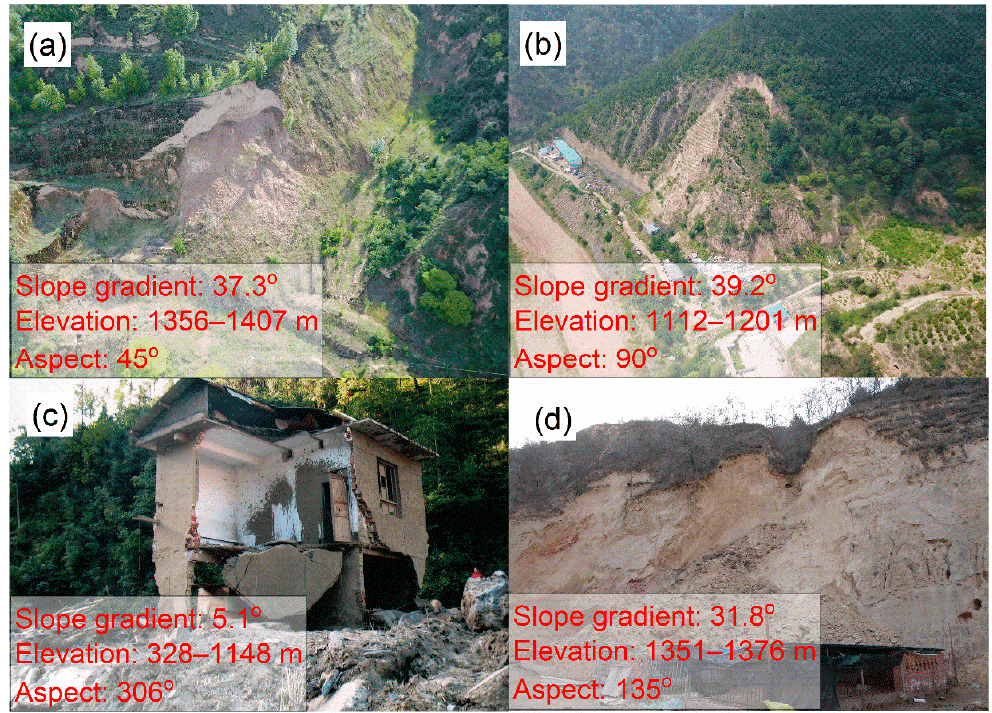
Figure 2. Photographs of typical landslides in the study area. ( a ) The slide that occurred on 30 July 2017 at 108°40 ′ 38 ″ , 36°53 ′ 39 ″ . ( b ) The slide that occurred on 1 August 2017 at 109°19 ′ 10 ″ , 36°50 ′ 45 ″ . ( c ) The debris flow that occurred on 7 August 2007 at 108°46 ′ 41 ″ , 32°30 ′ 39 ″ (photograph by Zhaoshu Li). ( d ) The fall that occurred on 30 July 2017 at 108°42 ′ 14 ″ , 36°52 ′ 26 ″ .